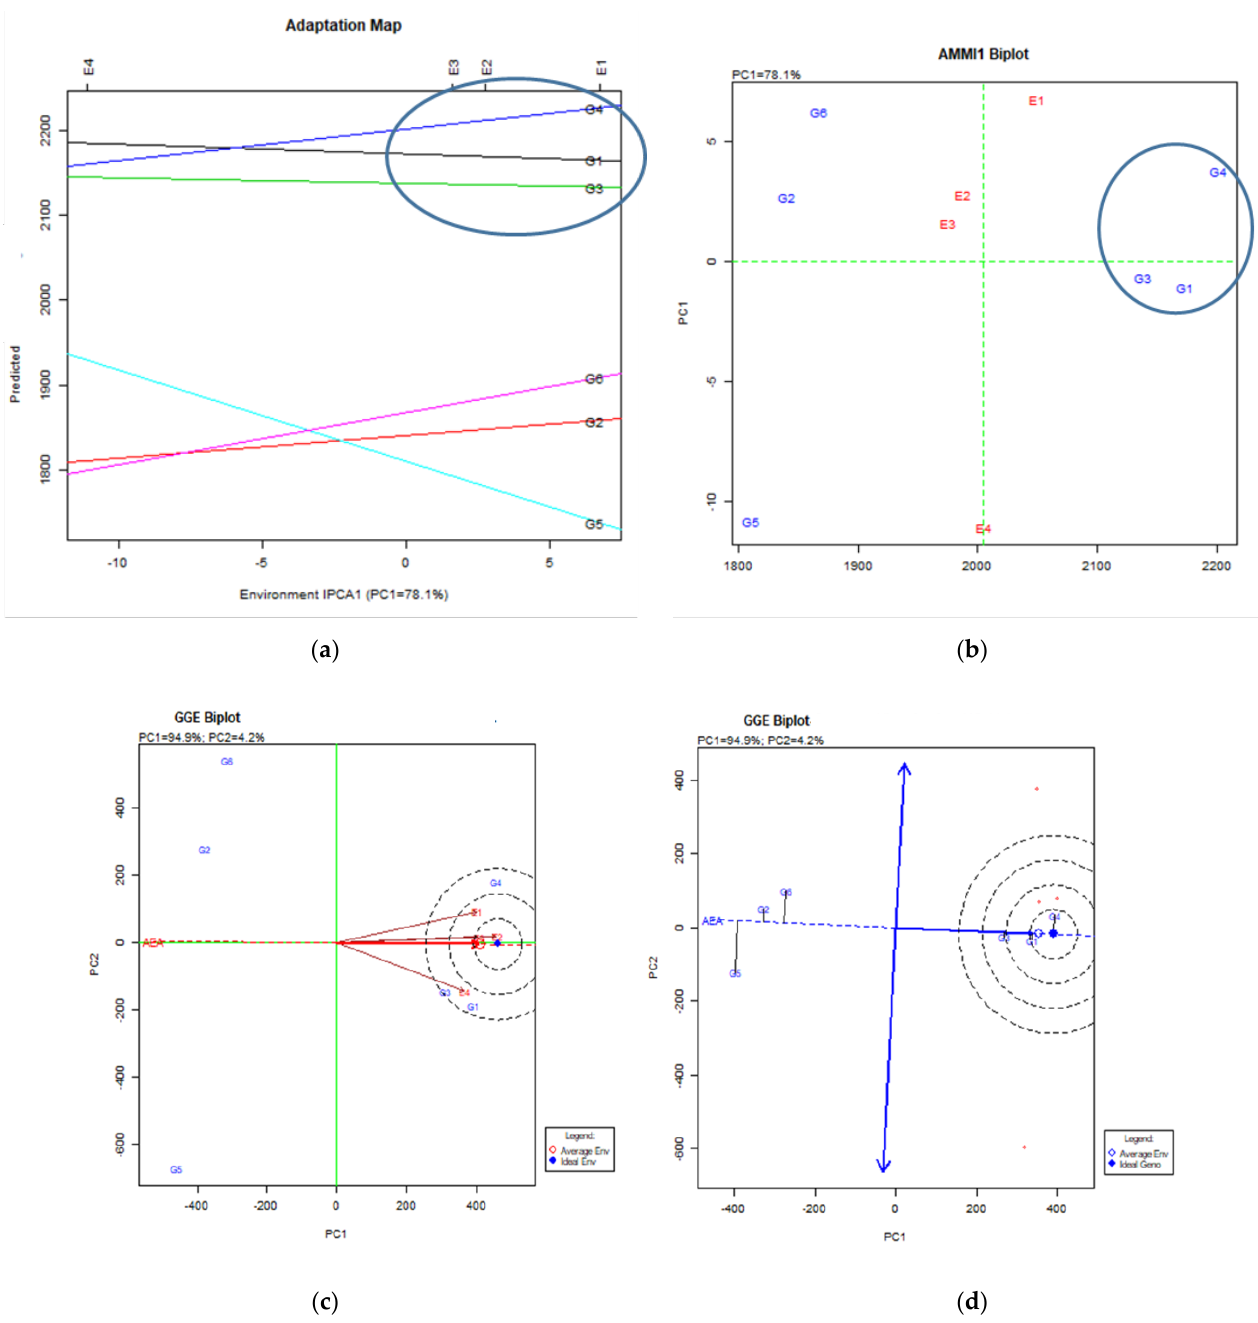
Figure 2. Stability analysis for seed yield (kg ha −1 ) based on ( a ) the adaptation map where the X-axis (PC1) visualizes the stability of varieties over environments and the Y-axis — the performance of varieties for the trait; ( b ) the AMMI1 biplot where the Y-axis is the one visualizing the trait performance and the X-axis (PC1) visualizes the stability of varieties over environments; ( c ) the GGE biplot for environments depicting the stability of the environments over years via the placement as near as possible to the ideal and average environment; ( d ) the GGE biplot for varieties depicting the stability of the varieties over environments where the productive varieties are those to the right on the AEA vector and the stable ones are those which are as close to the AEA axis as possible.